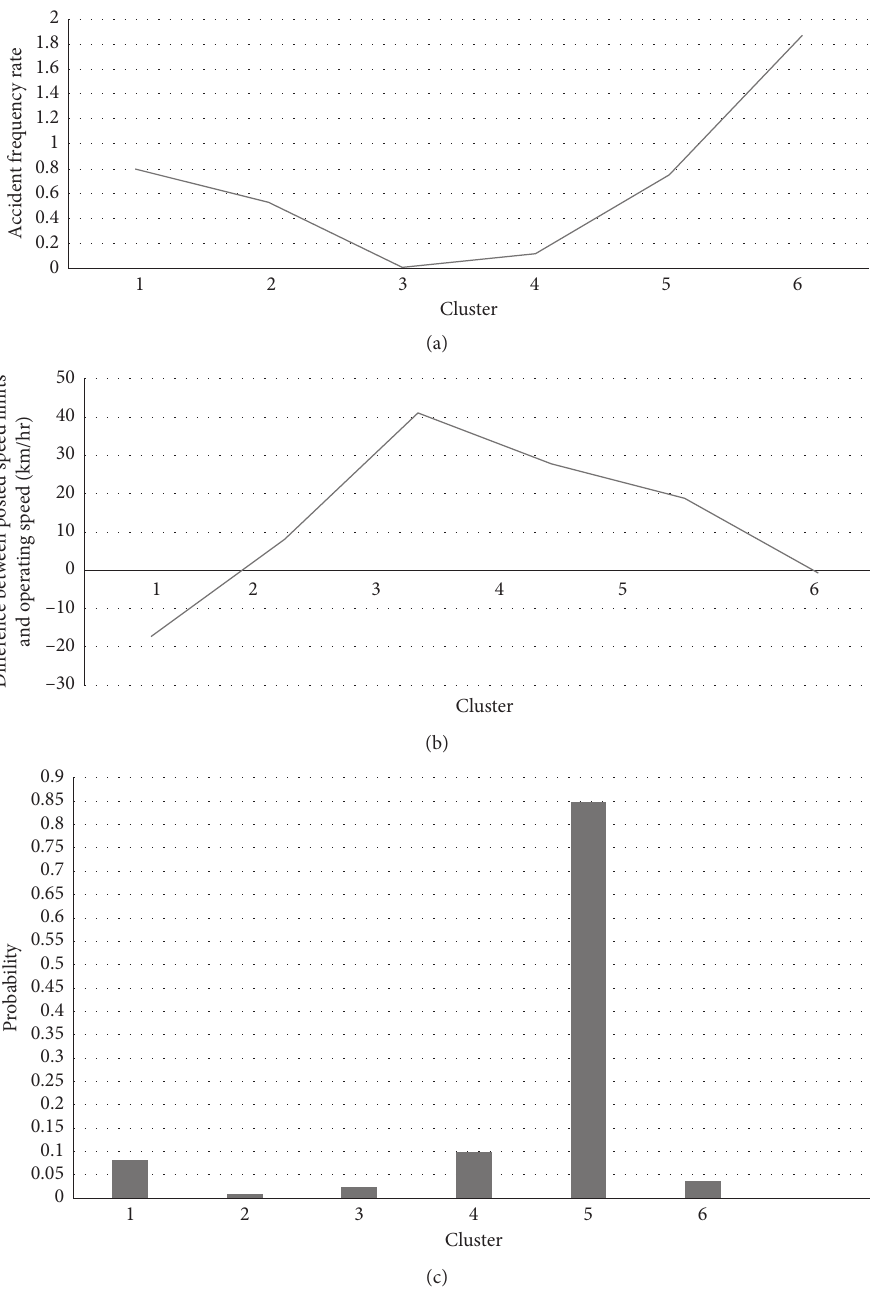
Figure 4: (a) Relationship between the cluster and accident frequency rate. (b) Relationship between the cluster and the difference between posted speed limits and the operating speed. (c) Relationship between the cluster and